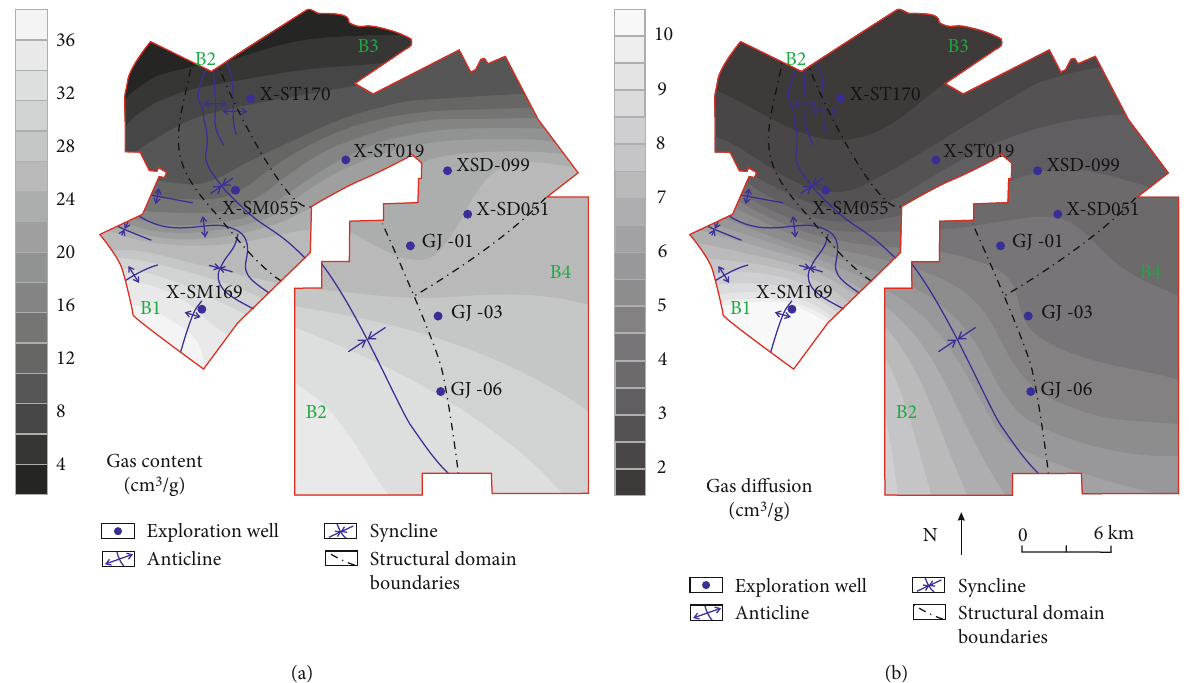
Figure 13: Distribution characteristics of gas content (a) at the end of the substage V